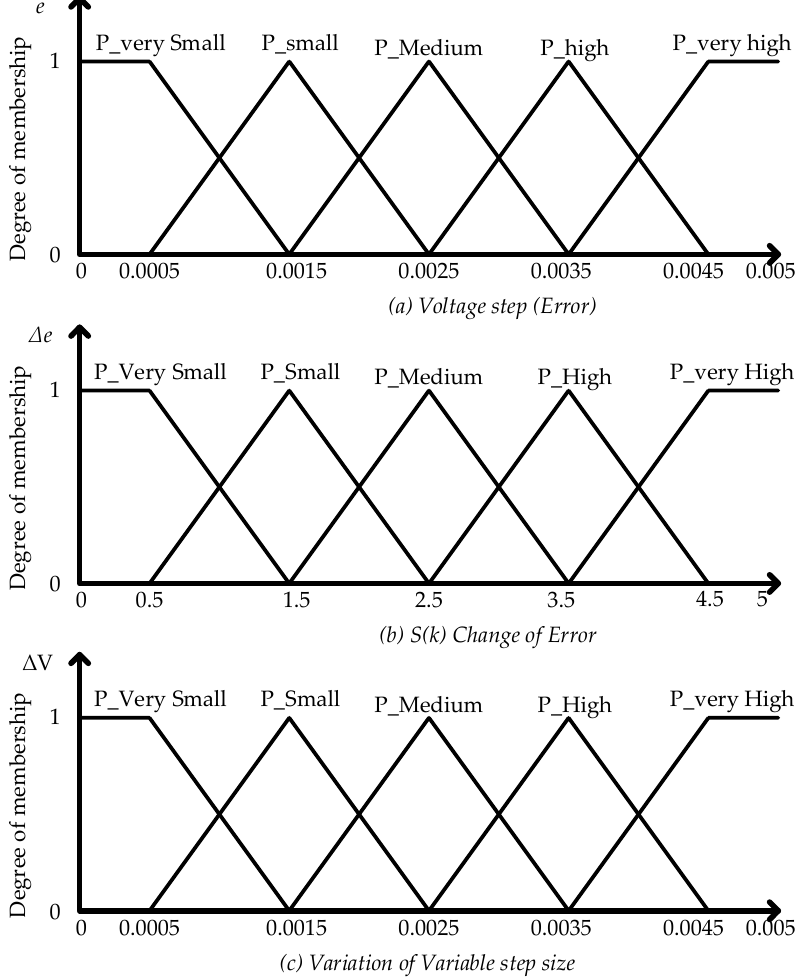
Figure 4 . The membership function of the proposed fuzzy logic controller for the variable step size MPPT algorithm ( a ) fixed step size perturbation; ( b ) PV curve slope S ( k ); ( c ) variable step ∆ V pv ( k ).